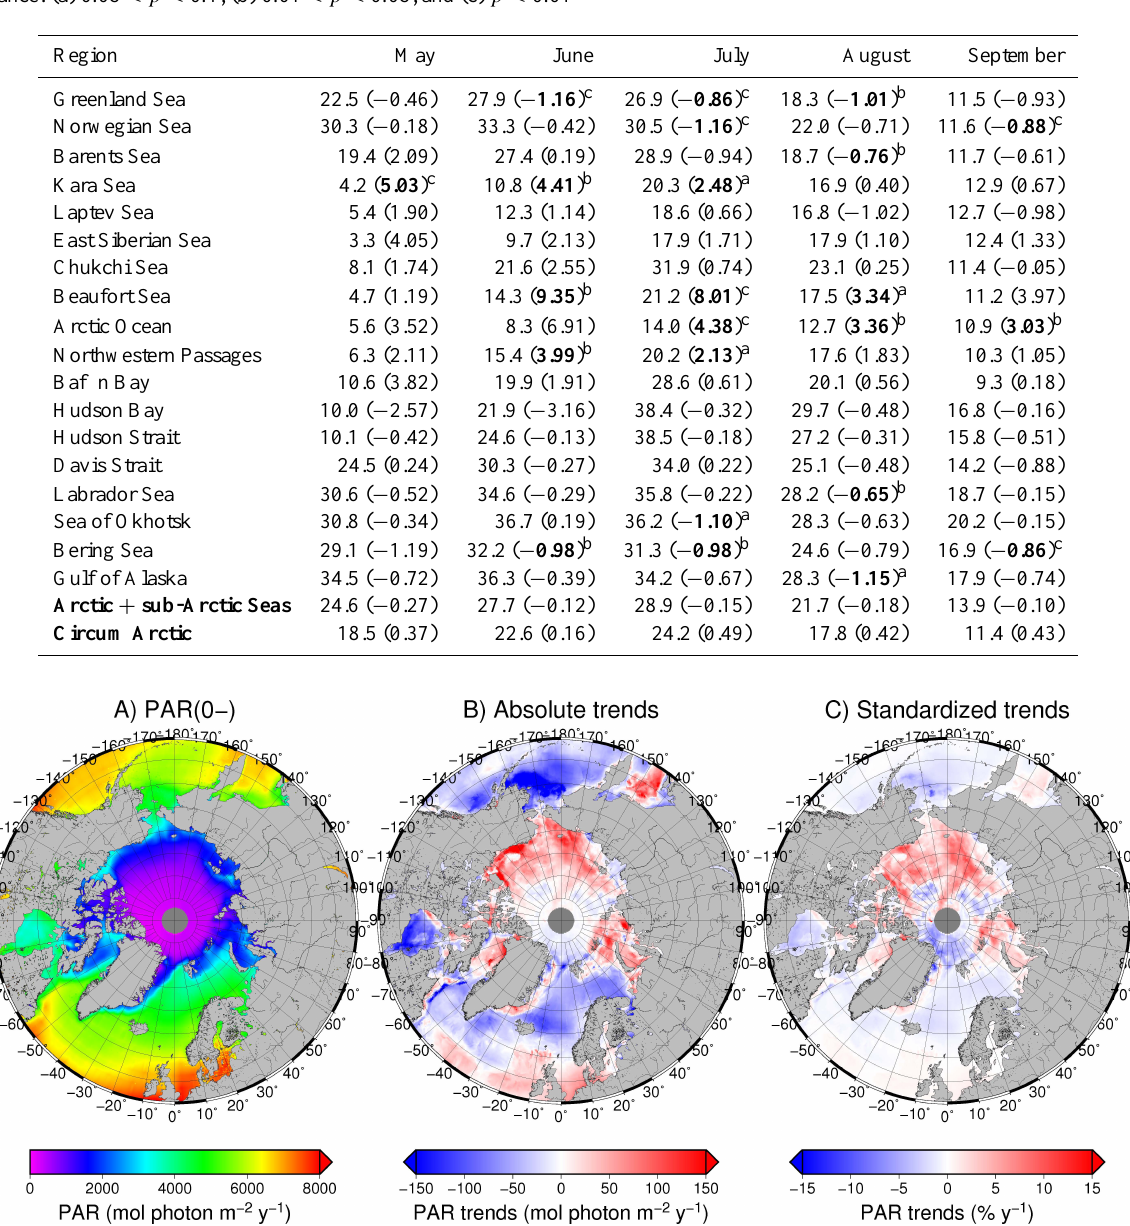
Table 2. Regionally averaged daily flux of PAR just beneath the sea surface (PAR(0 − ) in mol photon m − 2 d − 1 ) and its relative trends computed for the 1998 to 2009 period (in parenthesis, in %yr − 1 ). Significant trends are in bold text with superscript indicating the level of